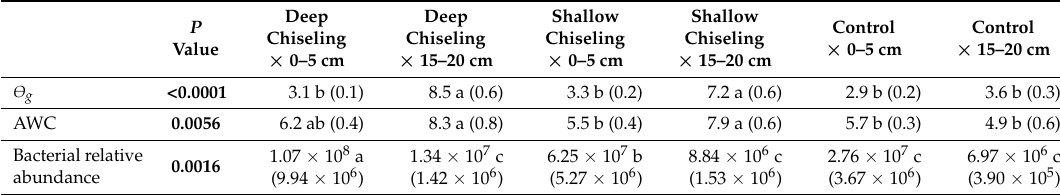
Table 1. Treatment effect on the soil surface roughness (%), penetration resistance (MPa), Table 3. Effect of the interaction treatment × depth on the gravimetric moisture content (